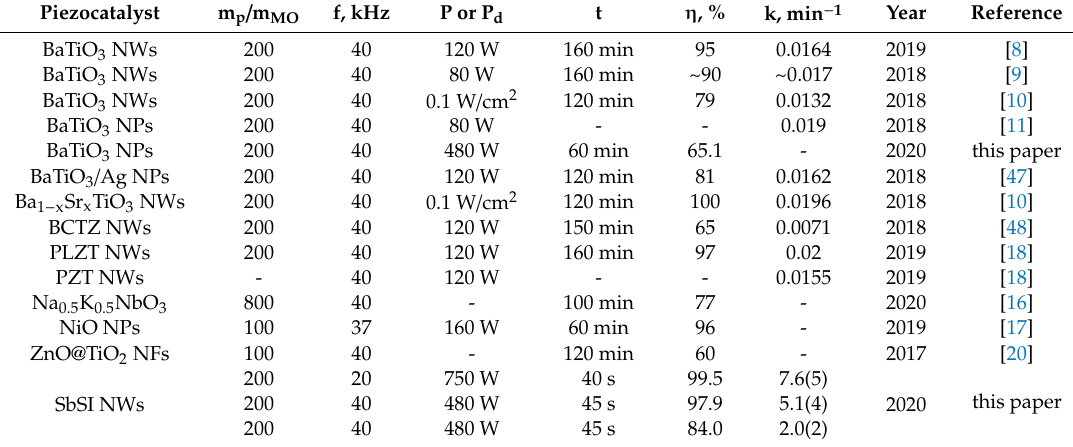
Table1. Acomparisonofe ffi cienciesofdi ff erentpiezocatalystsusedforultrasound-assisteddegradation of methyl orange (used abbreviations: BCTZ—(Ba 0.85 Ca 0.15 )(Ti 0.9 Zr 0.1 )O 3 ; f—ultrasounds frequency; k—reaction kinetics rate constant; m p / m MO —the ratio of piezocatalyst mass to the initial mass of methyl orange in aqueous solution; NFs—nanofibers NPs—nanoparticles; NWs—nanowires;